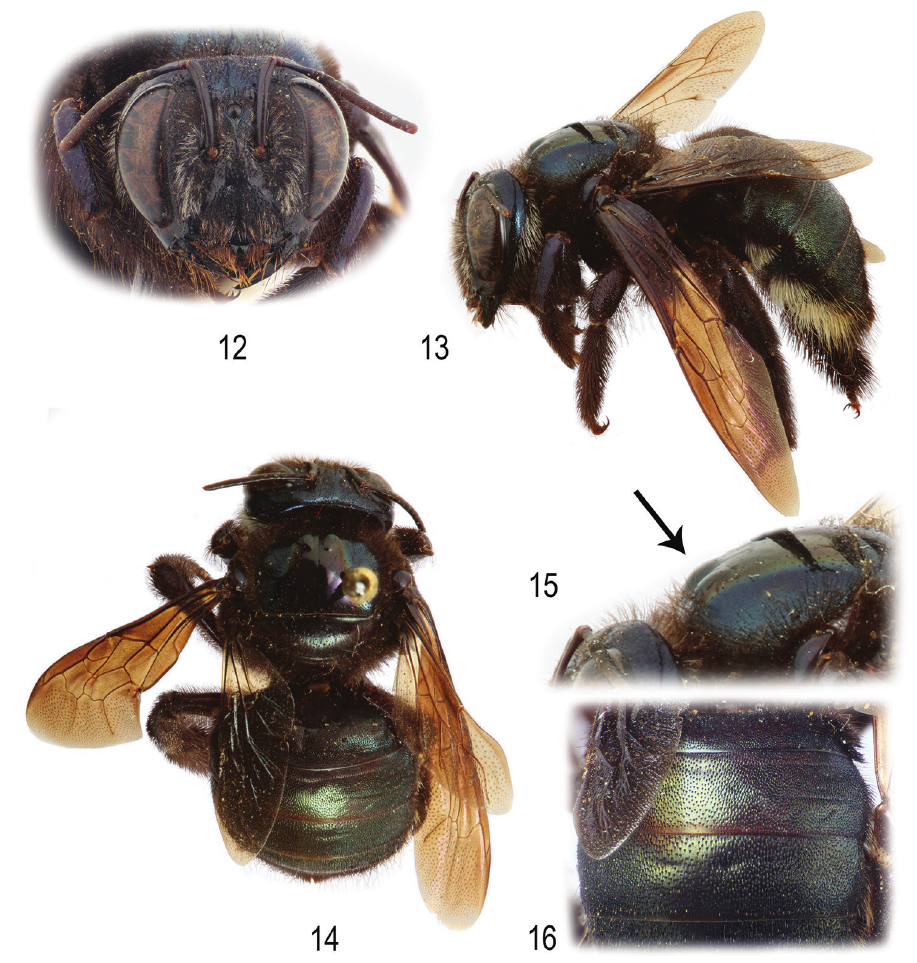
Figures 12–16. Female holotype of Xylocopa ( Schonnherria ) bigibbosa sp. n. 12 Facial view 13 Lateral habitus 14 Dorsal habitus 15 Detail of mesoscutum in profile with arrow pointing to tubercles 16 Detail of